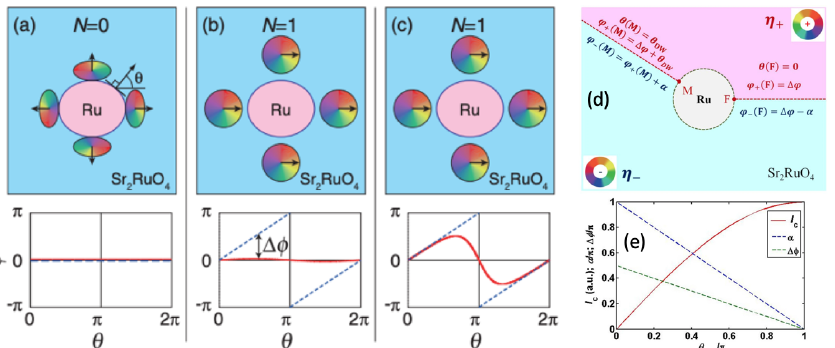
Figure 8. ( a – c ) Schematic illustrations of the superconducting order parameter at the SRO214/Ru interface. Upper panels present superconducting phase φ as a function of direction ( θ : normal to the surface) at each spatial position; arrows indicate the direction of momentum for φ = 0. Lower panels illustrate the directional dependence of φ ( θ ) at the SRO214/Ru interface in equilibrium state (without external current). The solid (dotted) lines represent the φ in Ru ( φ in SRO214). ( a ) At T c − bulk < T < T 3K − phase , the winding number N = 0: φ in Ru and SRO214 match. ( b ) At T c − bulk ≤ T phase winding N = ± 1 ,which is increasing the phase difference δφ . ( c ) At T < T c − bulk , the interfacial energy is increasing, which deforms δφ . (Adopted from [75] copyright APS 2011) ( d ) Schematic of two chiral-domain walls in SRO214 intersecting a circular Ru inclusion. The domain wall “F” is fixed at angle θ = 0, while domain wall “M” is movable with θ = θ DW , where α is the phase difference across a domain wall. ( e ) Calculated maximum I c , α and δφ depending on θ = θ DW . (Adopted with permission from [35] copyright NPG